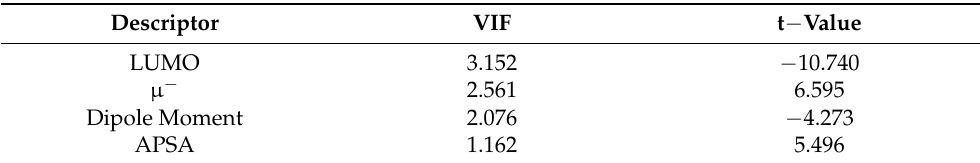
Table 3. The variance inflation factors (VIFs) and t-values of four descriptors in the quantum chemical GA-MLR model (Equation